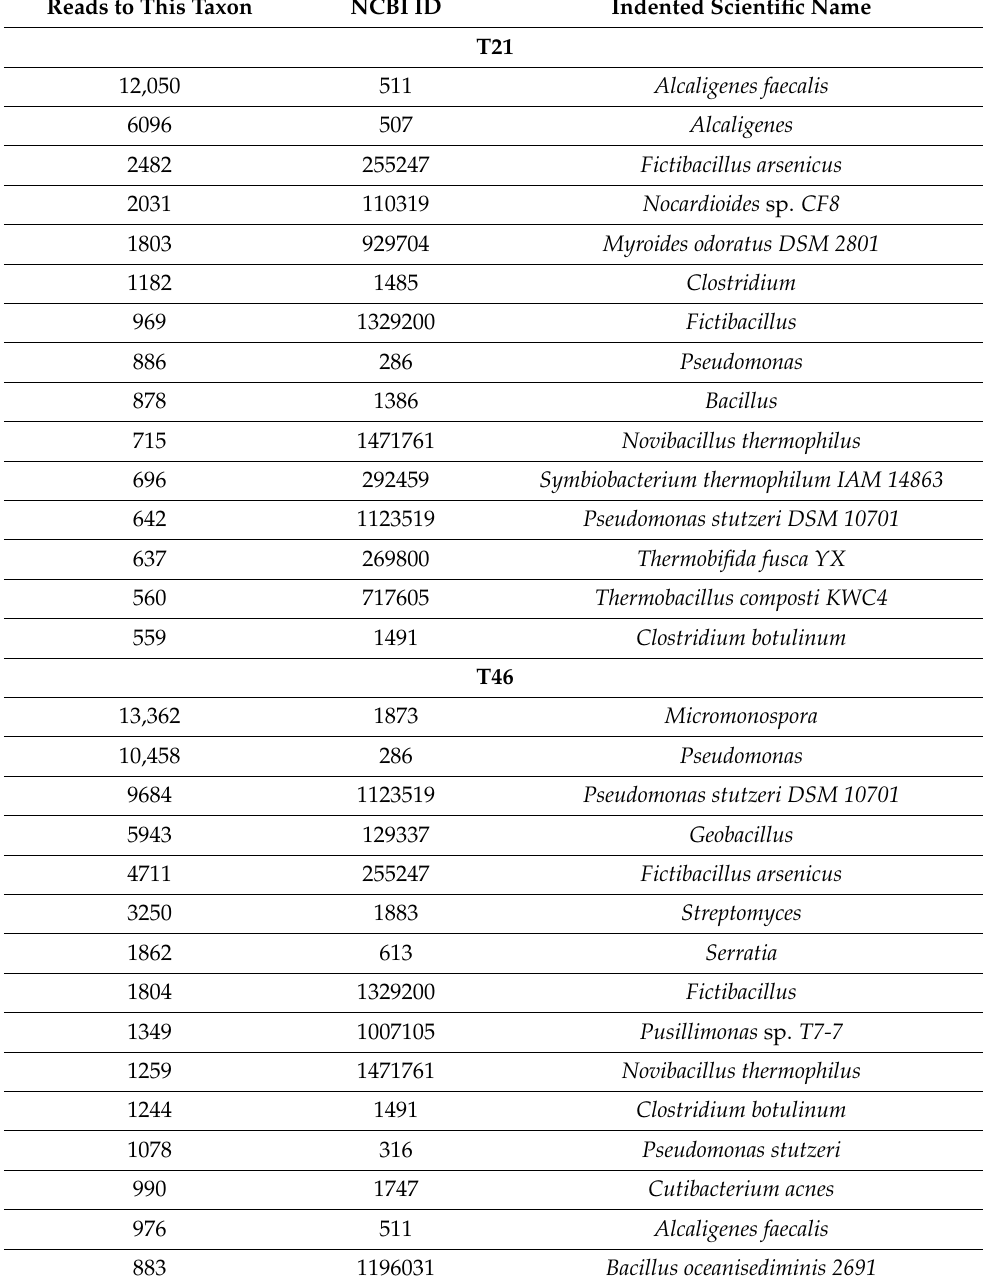
Table 3. Summary table for the top 15 hits for the bacterial organisms identified in the analysis. Reads to This